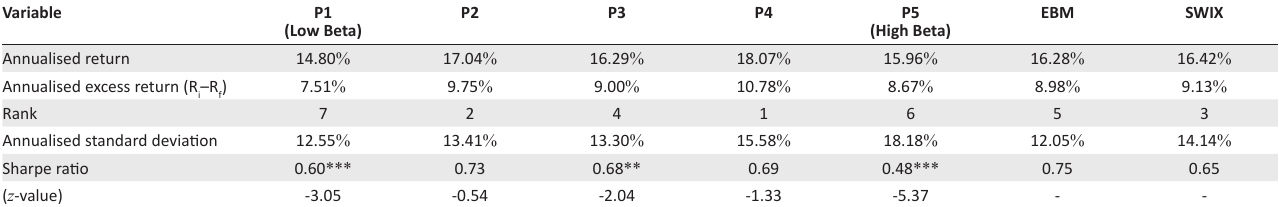
TABLE 1: Quintile portfolios based on historical beta.